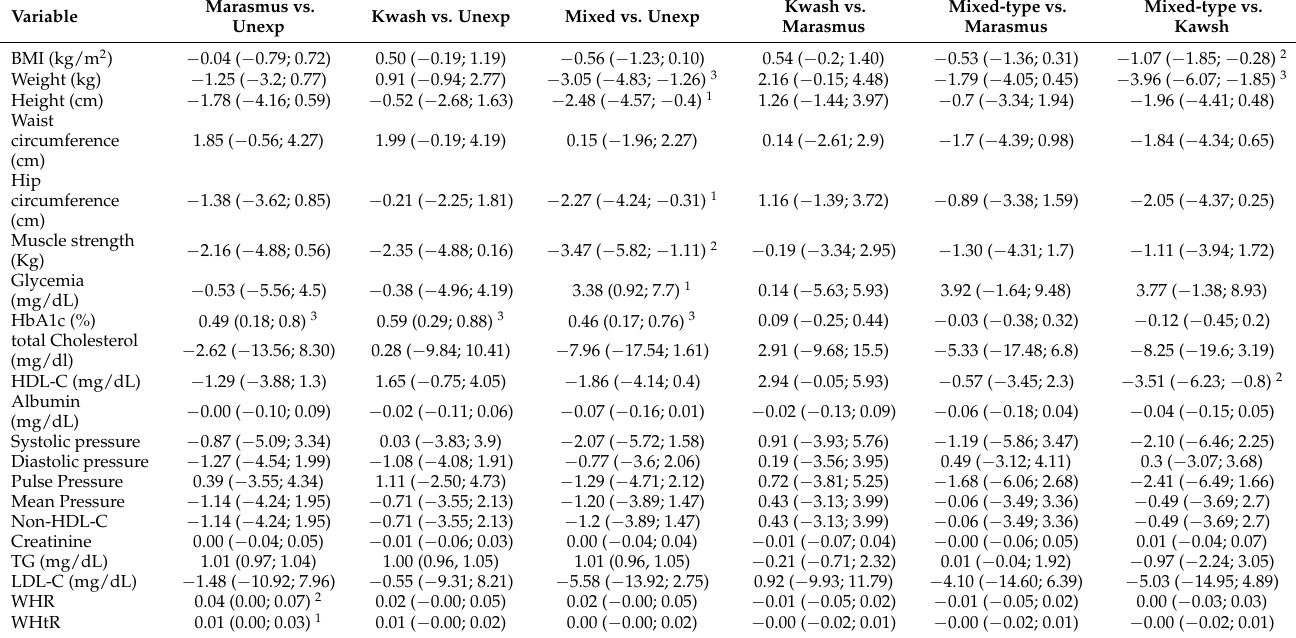
Table 5. Adjusted difference (95% CIs) of clinical and biological cardiometabolic markers be- tween